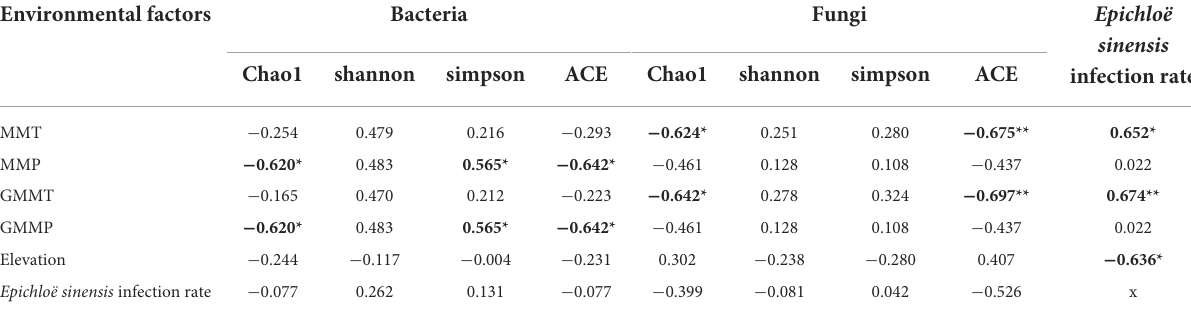
TABLE 3 Correlation coefficient between seed microbial α -diversity and environmental factors. Environmental factors Bacteria Fungi Epichloë